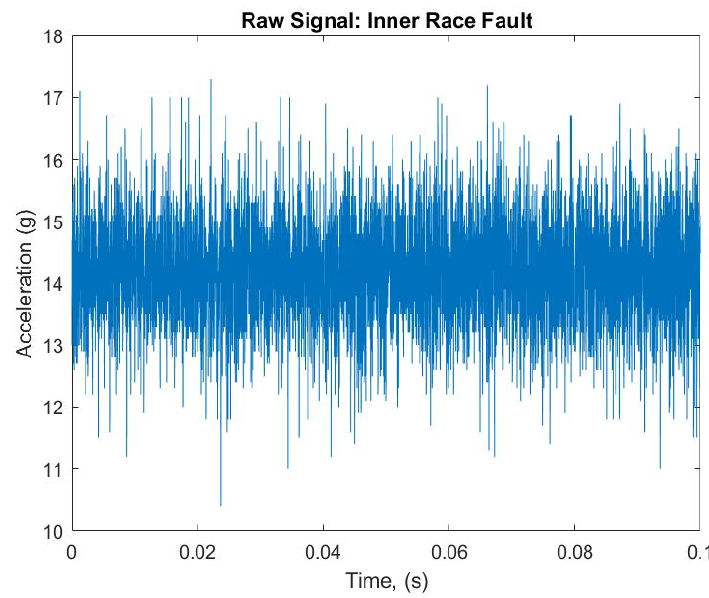
Figure 10. Raw signal of broken inner ring in time domain. The motor shaft speed is 300 rpm. At this frequency, it is difficult to detect failures frequency domain is presented.